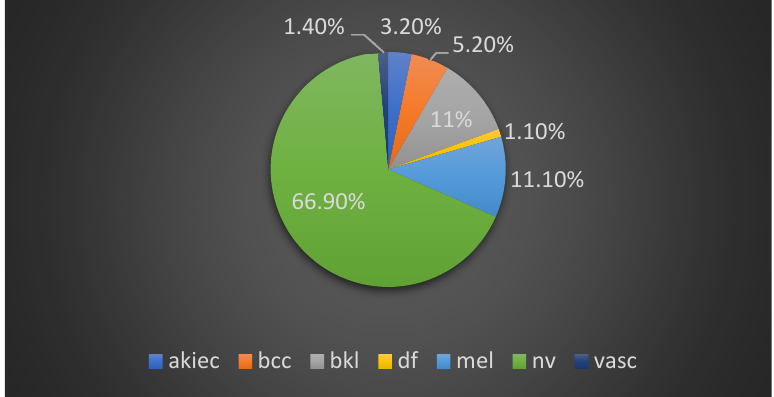
Figure 1. Distribution of images in HAM10000.